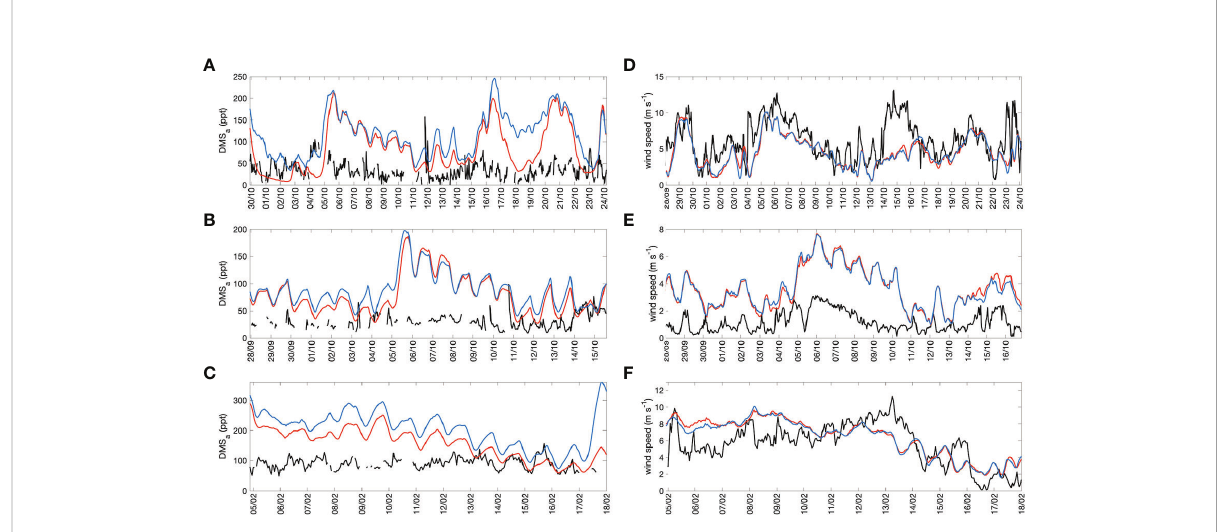
FIGURE 2 Time-series of observed (black) and modelled (left panels) DMS a and (right panels) wind speed for the L11 (orange) and GBR DMS (blue) simulations during the (A, D) RVI, (B, E) Mission Beach and (C, F) Heron Island surveys.